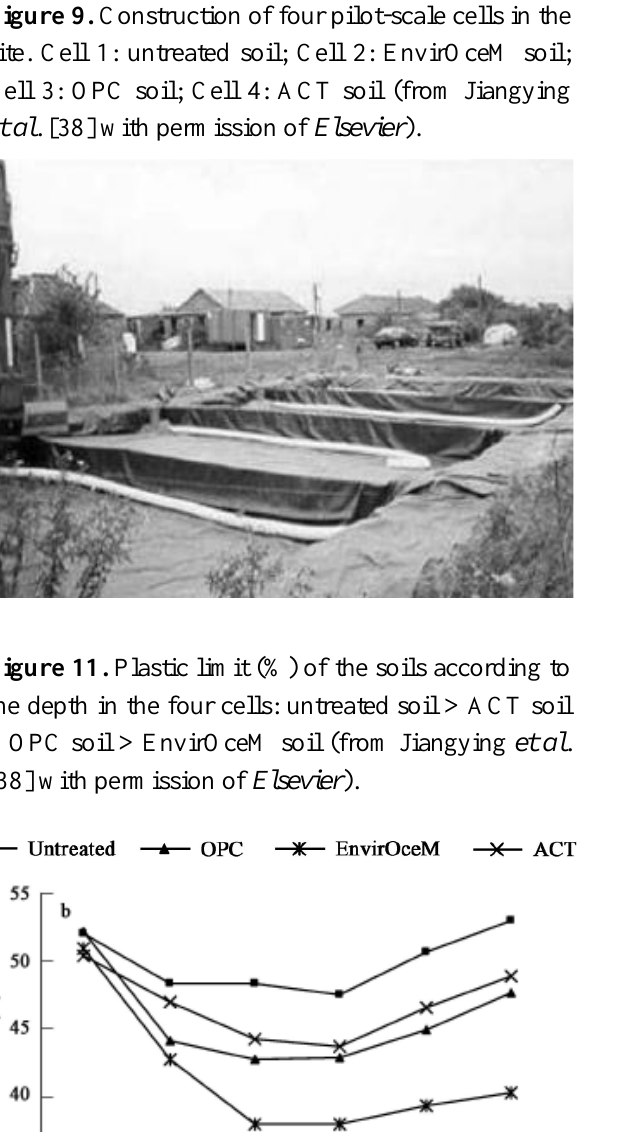
Figure 10. Accelerated carbonation treatment equipment (from Jiangying et al . [38] with permission of Elsevier ).